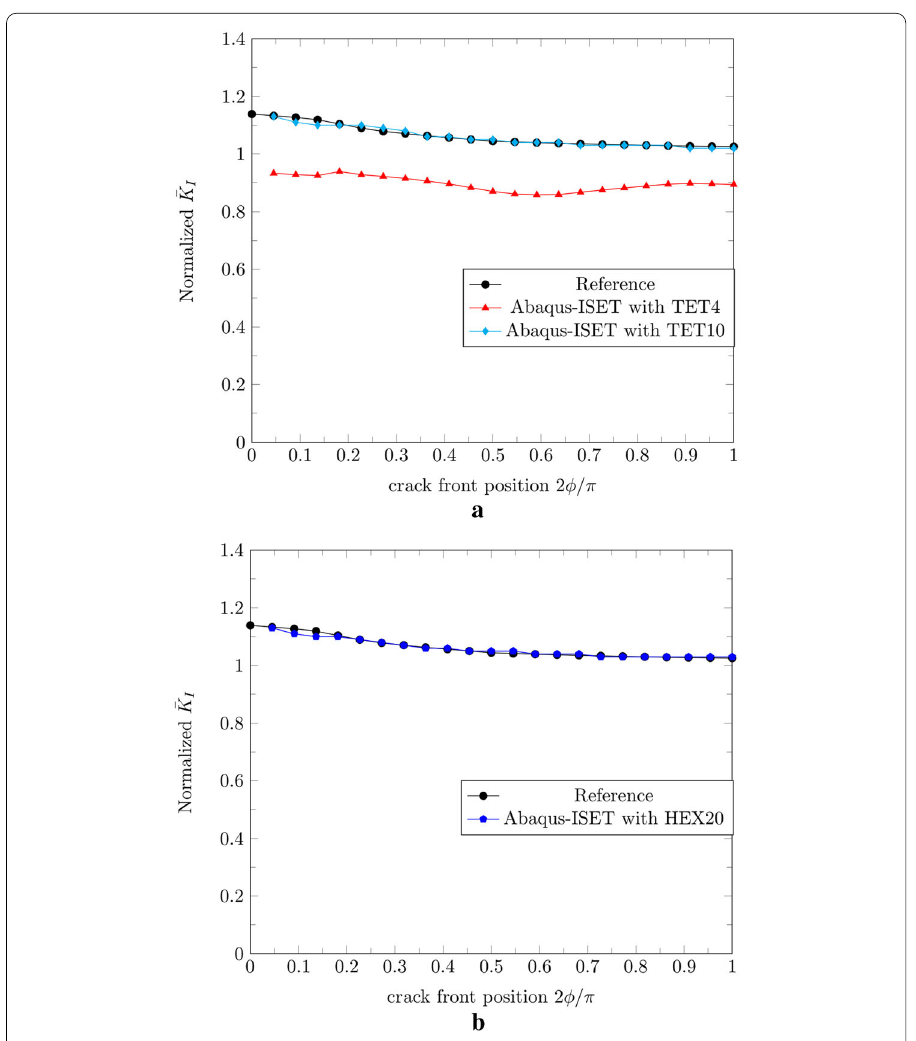
Fig. 16 Mode I stress intensity factor K I extracted from HNA Abaqus-ISET solutions for the surface-crack problem— a TET elements in the global problem— b TET elements in the global problem. The reference values are from Walters et al. [42]